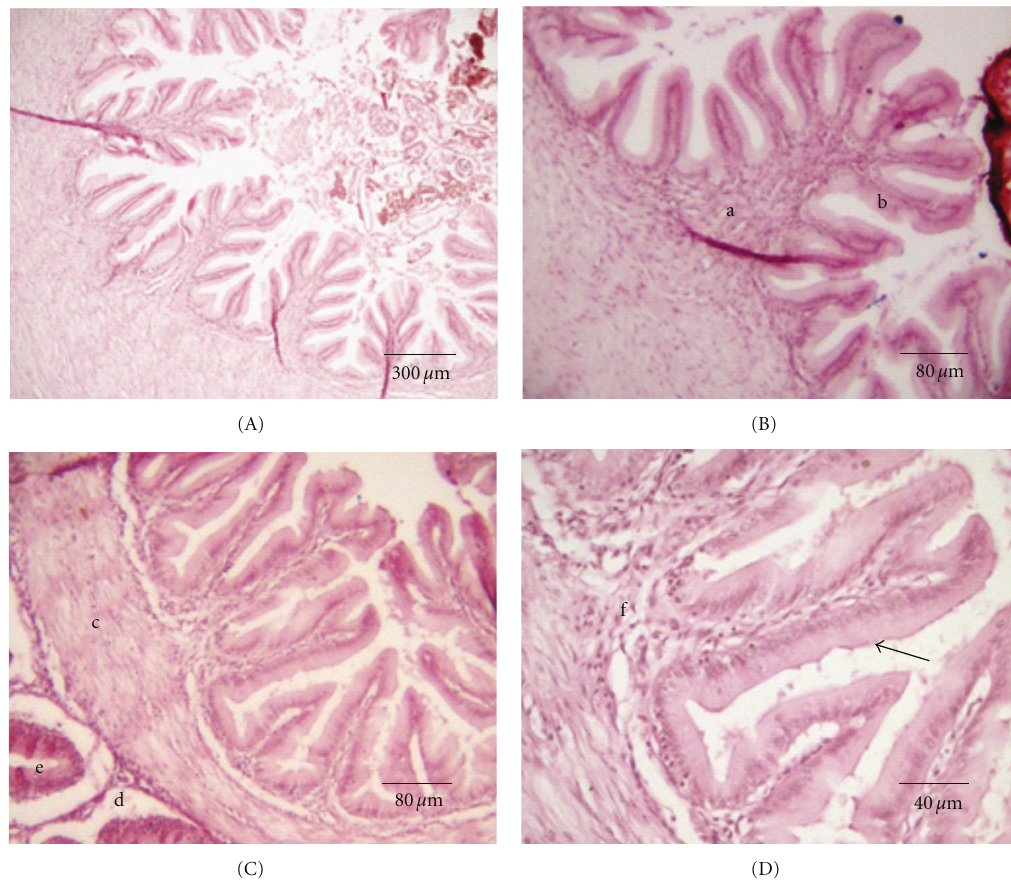
Figure 6: Pyloric stomach of S. fuscus: (A) pyloric folds in the stomach mucosa; (B) pyloric mucosa, primary fold (a) with evaginations of the lamina propria, with nonglandular secondary folds (b); (C) pyloric with muscles (c) serosa (d) with conjunctive of pyloric caeca (e); (D) pyloric folds with simple mucous secretory cylindrical epithelium (arrow) and nonglandular lamina propria